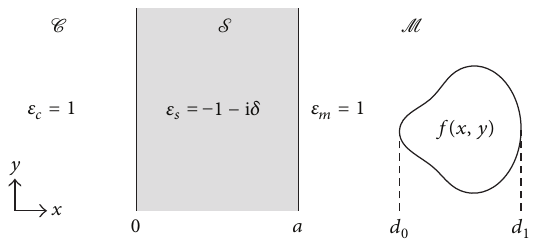
Figure 1: In this figure, we illustrate the geometry of the problem we consider in this